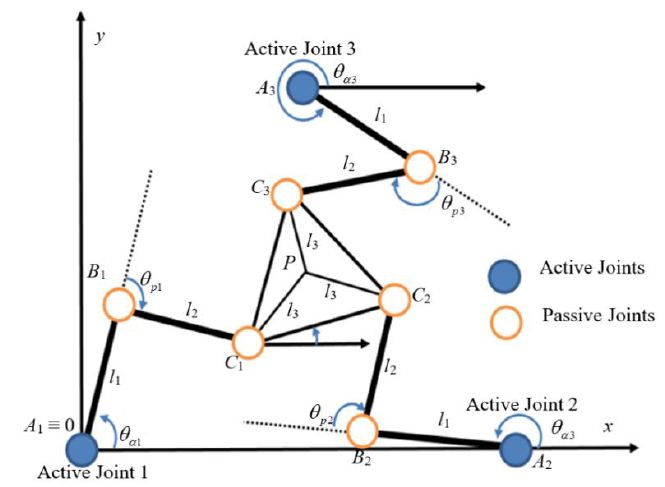
Figure 1. The kinematic illustration of the robotic system.